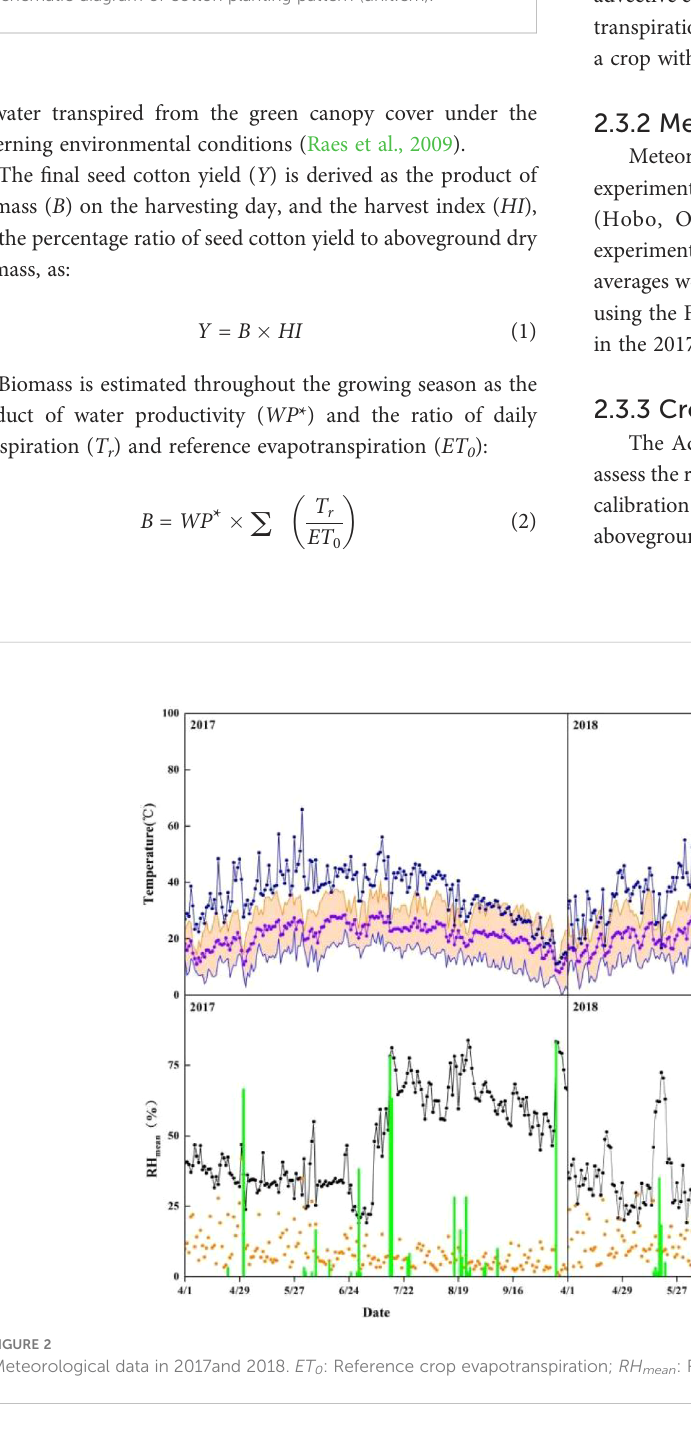
FIGURE 1 Schematic diagram of cotton planting pattern